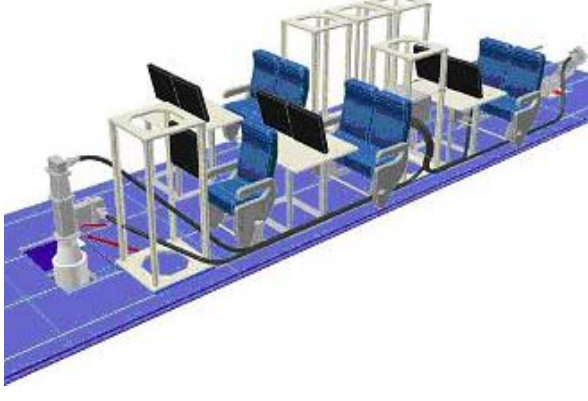
Figure 2. The CAROLS radiometer inside the ATR42 research aircraft, (a) illustration of nadir antenna inside the aircraft, (b) illustration of CAROLS system (receiver and antennas) inside the